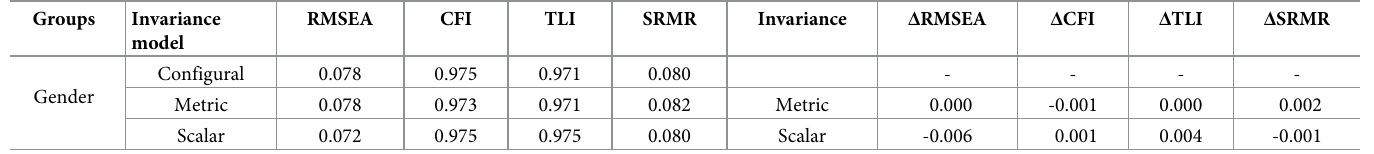
To compare the three models, we considered the differences of the three indices, CFI, SRMR and RMSEA among the three multi-group models (configural vs metric and metric vs scalar). Invariance is verified if there is a difference of CFI less than or equal to 0.010, a differ- ence of RMSEA less than or equal to 0.015, and a difference of SRMR less than or equal to 0.030 in the configural vs metric comparison and less than or equal to 0.010 in the metric vs scalar comparison [96]. The values in Table 2 testify to the presence of invariance by gender.